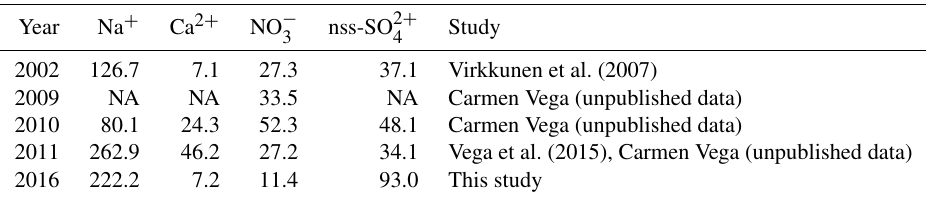
Table 4. Loads (mgm − 2 ) of selected major ions from the 2016 sampling and from earlier studies at the Lomonosovfonna summit (LF3), corresponding to the concentrations given in Fig. 4.